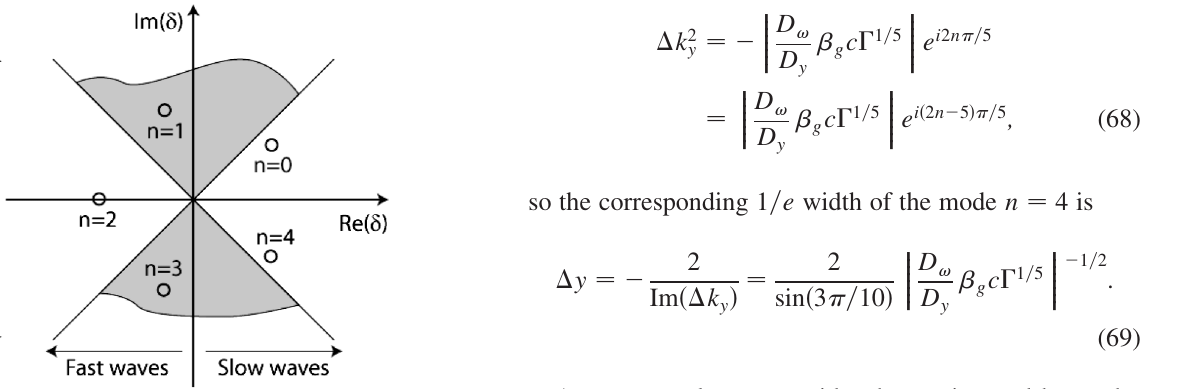
FIG. 5. Roots of the dispersion relation for region I. Forbidden regions are